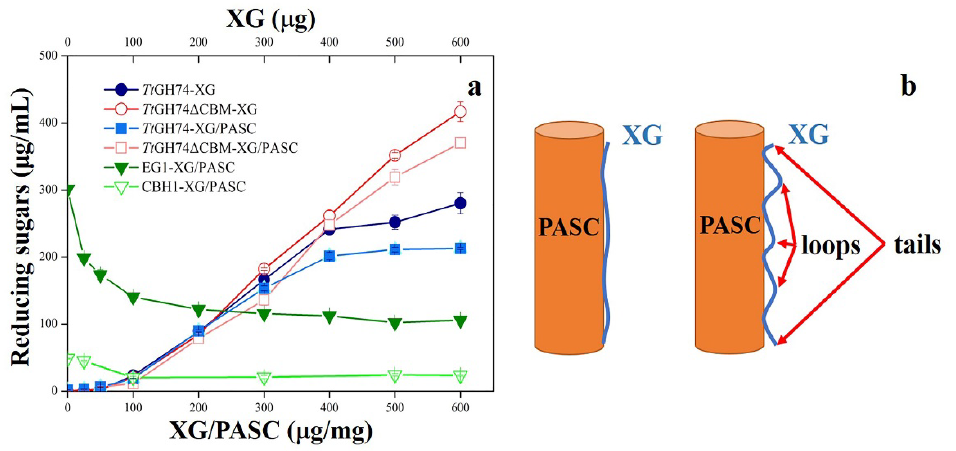
Figure 5. Hydrolysis of Tt GH74 and Tt GH74 ∆ CBM on different amounts of XG, Tt GH74, Tt GH74 ∆ CBM, EG1 and CBH1 hydrolyze PASC coated with different proportions of XG, respec- tively ( a ). The schematic diagram of the association pattern of XG and PASC ( b ). Orange cylinders represent PASC, and XG is represented by a blue line. The left diagram shows the low proportion of XG/PASC; the right diagram shows the high proportion of XG/PASC; and the XG forms accessible “loops” and “tails” on the PASC surface.